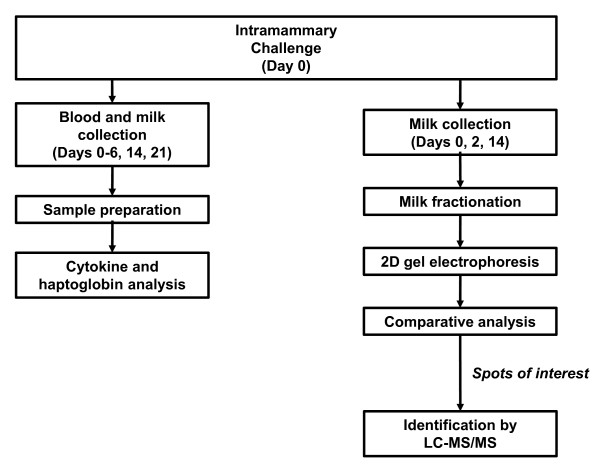
Flow chart of study outline.